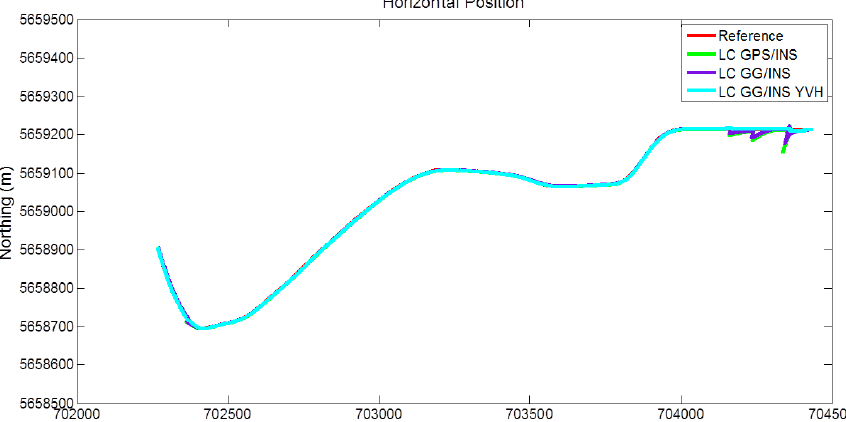
Figure 12. Trajectories obtained with the loose coupling approach (Segment